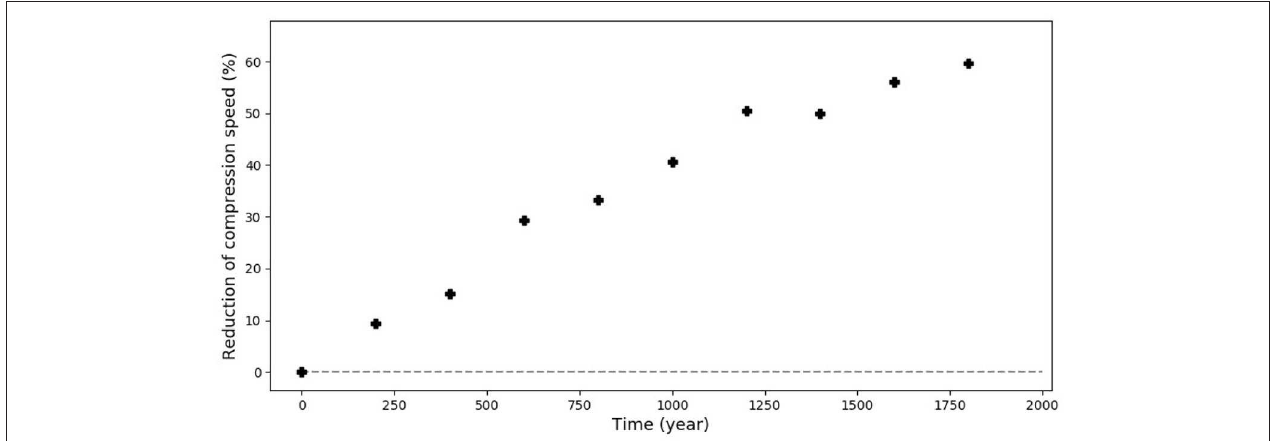
FIGURE 8 | Reduction of the compression speed of closed pores due to the building of pressure. The dashed line represents a non reduced compression speed, as in the constant pressure case.